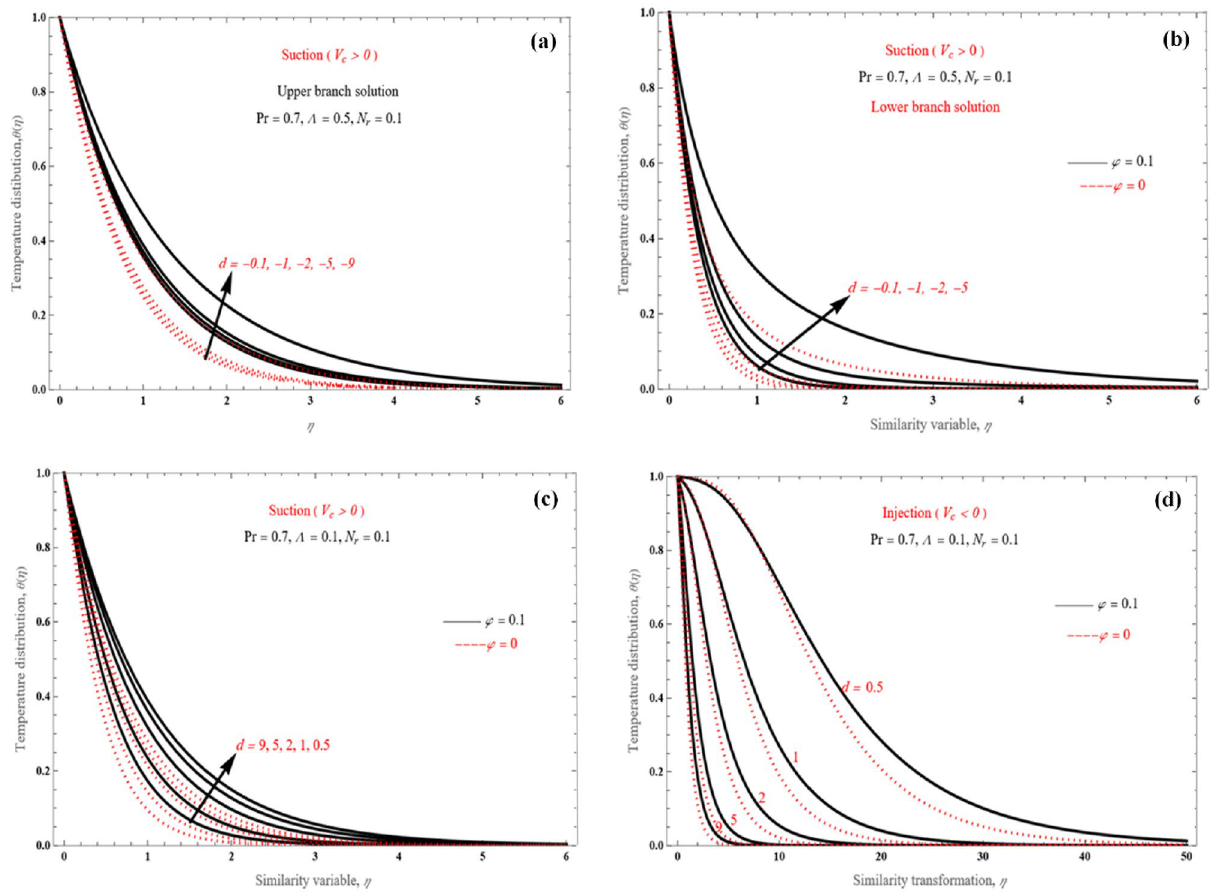
Figure 11. Temperature profiles for ( a ) shrinking sheet, upper branch solution, ( b ) shrinking sheet, lower branch solution, ( c ) stretching sheet, suction, and ( d ) stretching sheet, injection